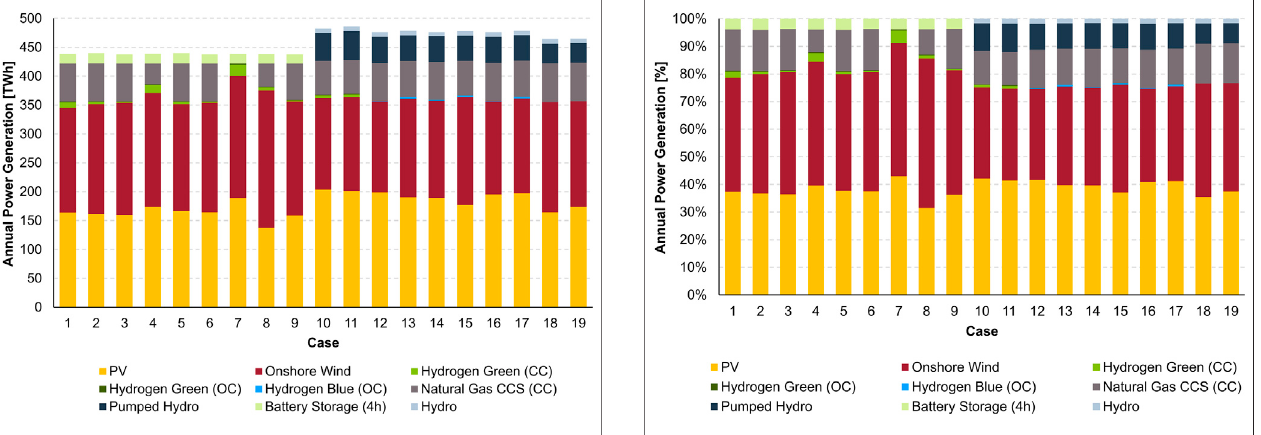
FIGURE 4 | Total annual power generation by technology type for each case in TWh.